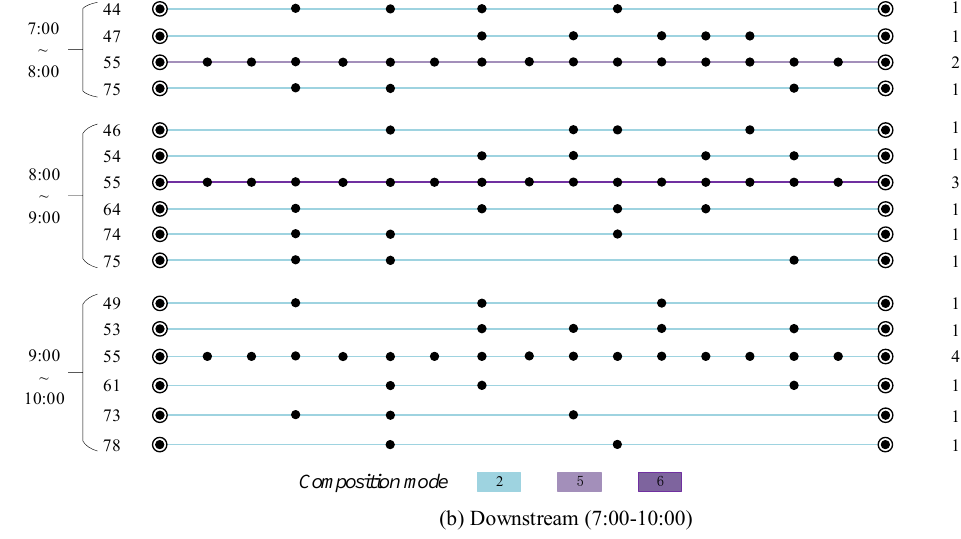
Figure 6. The line planning scheme in the up and downstream direction during the peak hours.